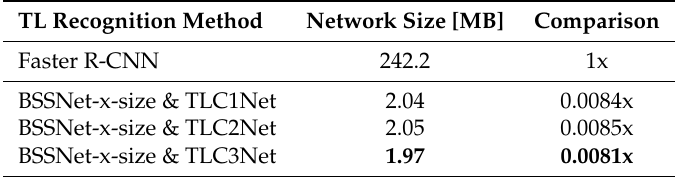
Table 6. Hardware requirements according to the TL